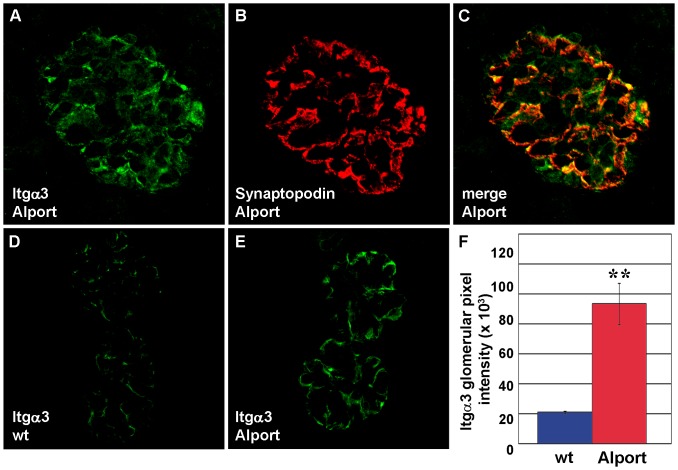
Integrin α3 protein is upregulated in podocytes of Alport glomeruli.A–C: Fresh frozen kidney sections from 4 week old Alport mice were labeled with a combination of rabbit anti-integrin α3 and mouse anti-synaptopodin IgGs, followed by the appropriate species-specific Alexa Fluor secondaries. Anti-integrin α3 immunolabeling (A) is restricted to the epithelial podocyte layer, marked by synaptopodin staining (B), and overlap of staining is shown in C (merge). D–F: Representative fluorescence micrographs are shown of anti-integrin α3 labeling of wild-type (D, wt), or Alport (E) mouse glomeruli. The glomerular fluorescence intensities were averaged for n = 3 mice of each genotype, wild-type (wt, blue) or Alport (red), and integrin α3 signals were significantly greater in Alport. * p = 0.006.